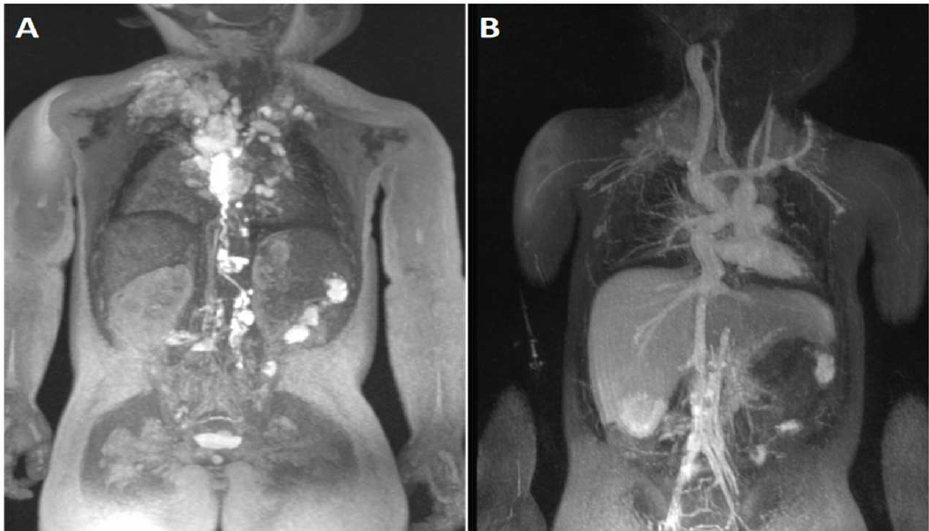
Figure 13. Combined MR Lymphangiography and FE-MRA. Panel ( A ): Coronal maximum intensity projection of a breath-held T2-weighted MR lymphangiogram performed after administration of dilute gadolinium via groin cannula. Panel ( B ): Coronal maximum intensity projection of a breath- held FE-MRA is also obtained to obtain the vascular anatomy and “overlay” the two images to guide transcatheter lymphatic therapy.